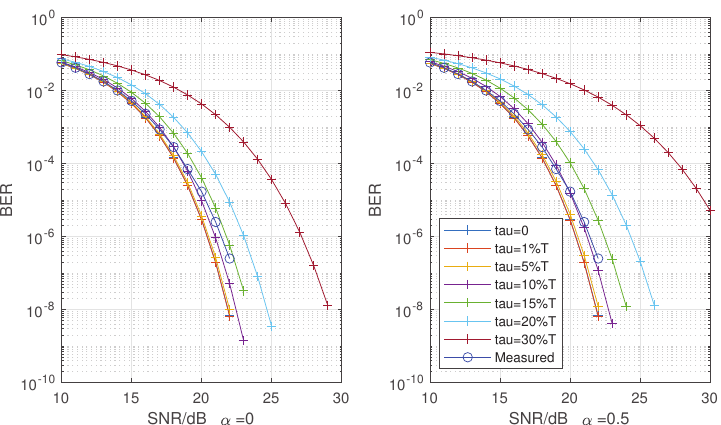
Figure 13. Measured BER of 16 QAM and theoretical at roll-off α = 0 ( left ) and α = 0.5 ( right ) with RC.